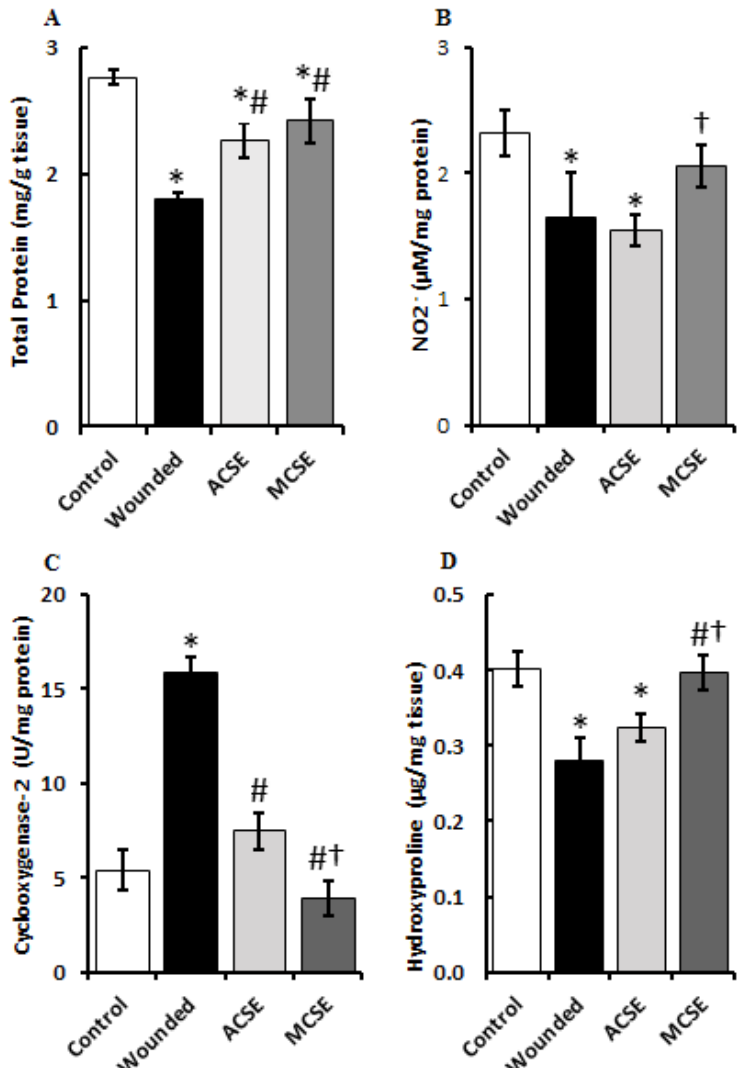
Figure 2: Total protein, nitrite (NO 2- ), cyclooxygenase-2, and hydroxyproline in wound tissues following treatment with corn silk extracts. ACSE, aqueous corn silk extract; MCSE, methanolic corn silk extract. Bars indicate mean±SEM (n = 5); *, #, and †indicate significant difference at p< 0.05 as compared with control, wounded and ACSE